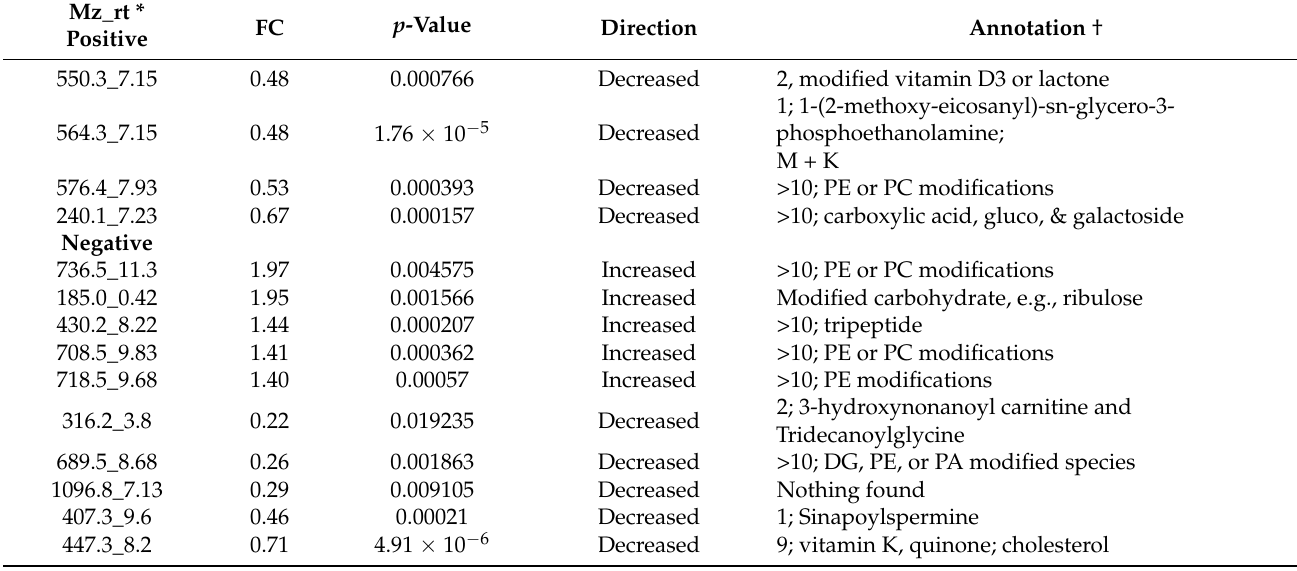
Figure 7. Targeted lipidomics reveals a number of up-regulated species. ( A ) Volcano plot; ( B ) hier- archical clustering (top 25) of metabolites (by p -value); key shows relative levels of metabolites (log2